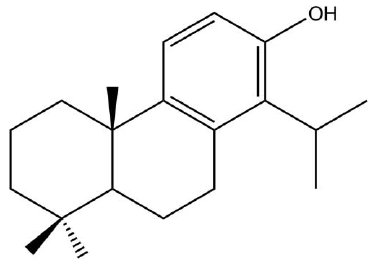
refinement: CrysAlis RED (Oxford Diffraction, 2006); data reduc- tion: CrysAlis RED ; program(s) used to solve structure: SIR97 (Altomare et al. , 1999); program(s) used to refine structure: SHELXL97 (Sheldrick, 2008); molecular graphics: ORTEPIII (Burnett & Johnson, 1996) and ORTEP-3 for Windows